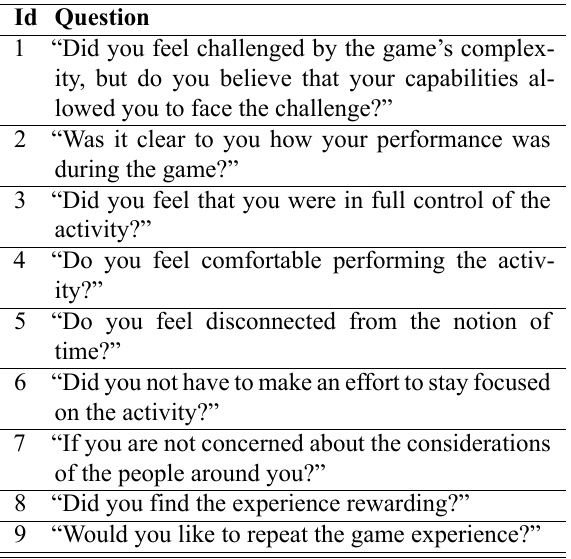
Table 3. Patient‘s